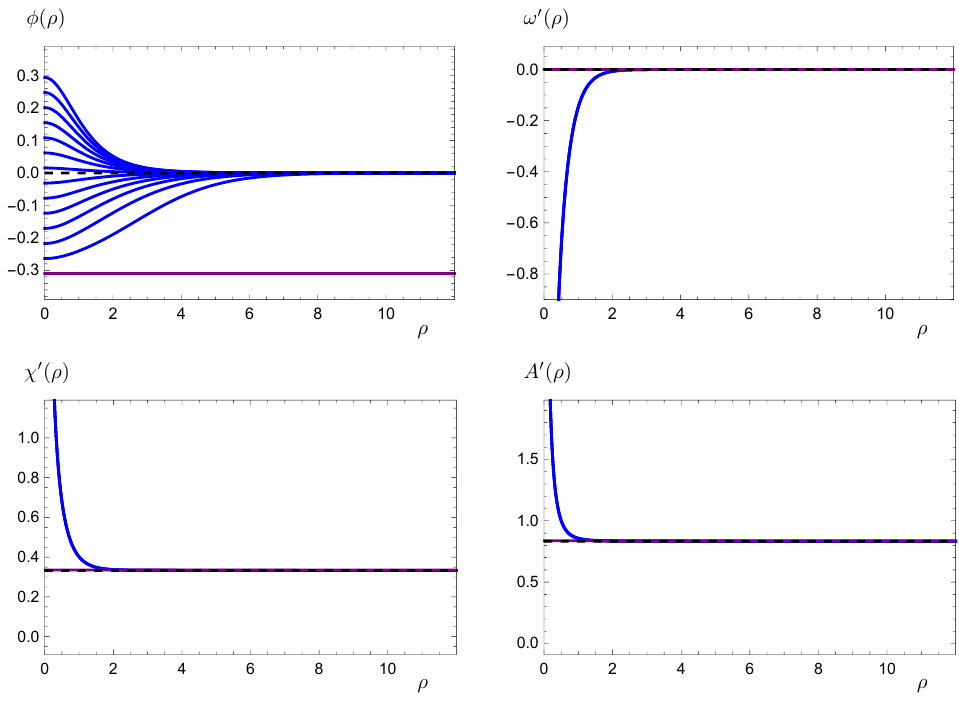
Figure 1 . Background fields in illustrative examples of confining solutions with ρ o = 0 . Left to right and top to bottom: the functions φ ( ρ ) , ω 0 ( ρ ) , χ 0 ( ρ ) , and A 0 ( ρ ) . For comparison, the horizontal lines represent the DW solutions at the φ (black, dashing) and φ (purple, continuous). In confining UV IR solutions, ω , χ , and A diverge at the end of space, but φ is